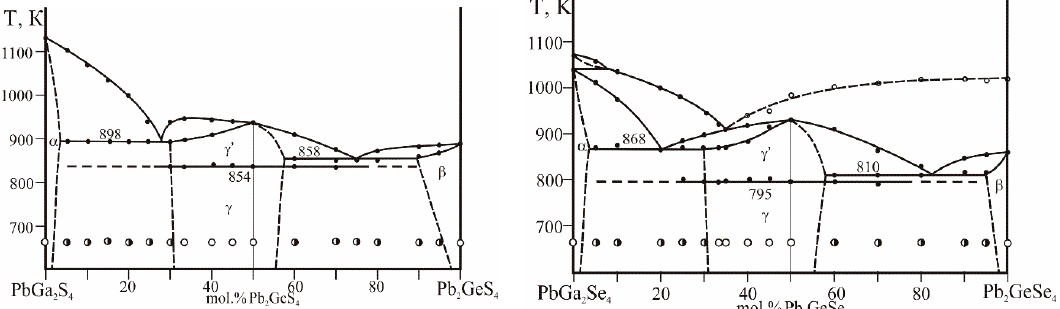
Figure 2. Phase diagrams of the PbGa 2 S(Se) 4 − Pb 2 GeS(Se) 4